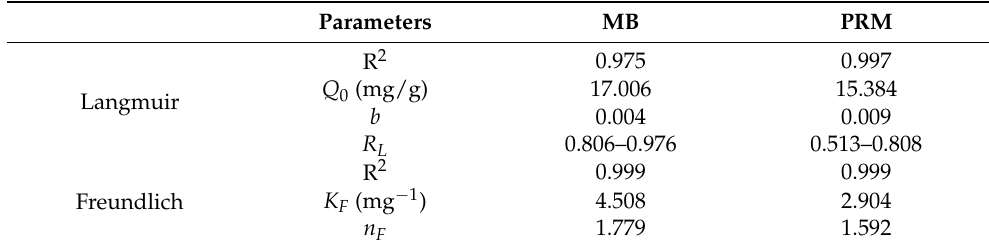
Table 2. Langmuir and Freundlich parameters for MB and PRM adsorption while using the HCWS3 adsorbent.